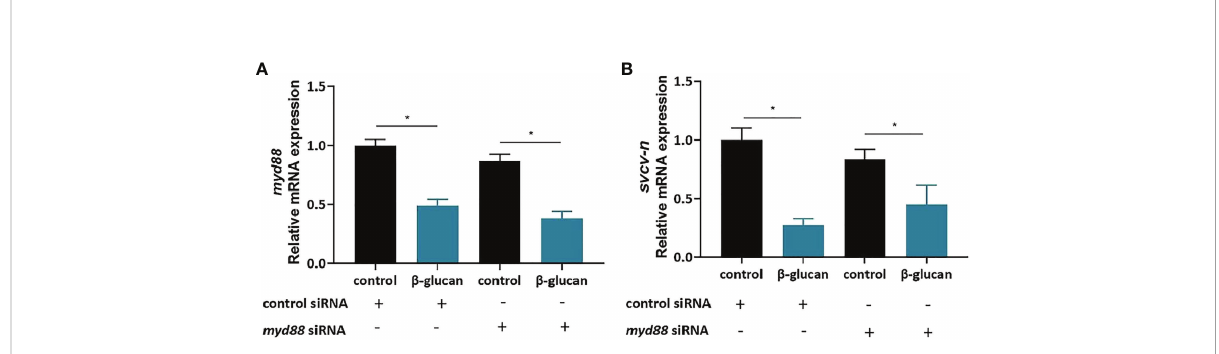
FIGURE 8 Myd88 is not required for b -glucan to protect against SVCV infection. (A) The knockdown ef fi ciency of myd88 (n = 6); (B) Effects of b -glucan on the mRNA expression of SVCV N protein after siRNA knockdown of myd88 (n = 6). Values represent the means ± SEM. * P <